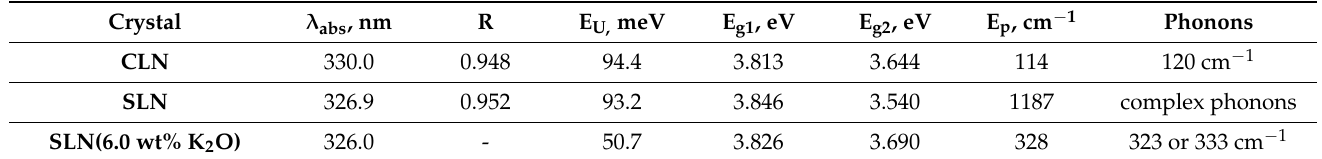
Table 1. Optical characteristics of the crystals, ∆ λ abs = ± 0.1